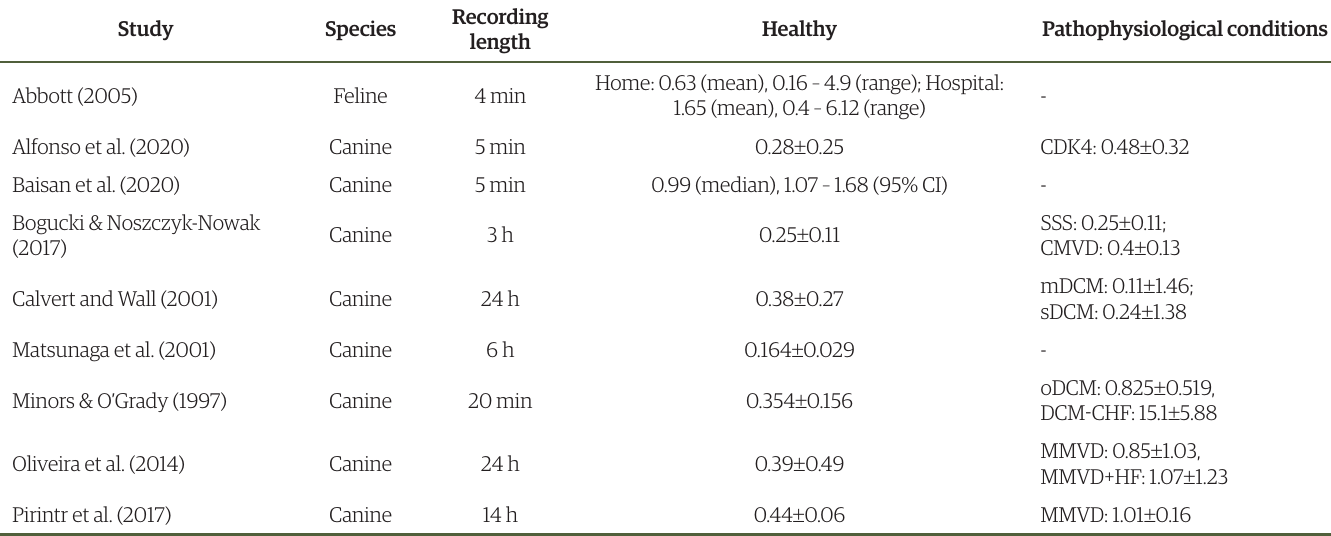
SSS, sick sinus syndrome; CKD4, chronic kidney disease stage 4; MMVD, myxomatous mitral valve disease; HF, heart failure; DCM-CHF, Dilated cardiomyopathy-chronic heart failure stage; CI, Confidence Interval; mDCM, mild/moderate dilated cardiomyopathy; sDCM, severe cardiomyopathy; oDCM, occult dilated cardiomyopathy. Data are presented as mean ± standard deviation, unless stated